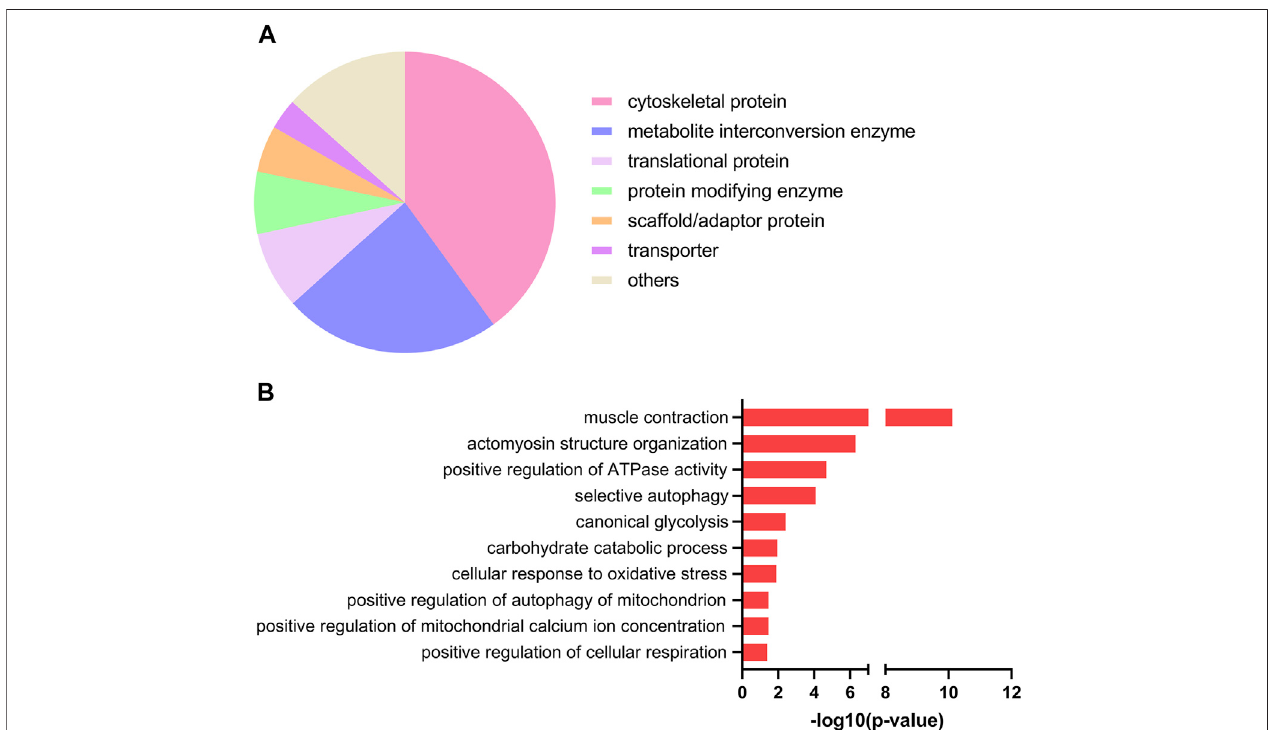
FIGURE 2 | Protein classi fi cation and selected gene ontology (GO)-biological processes of upregulated proteins in electrical pulse-stimulated myotubes from young male subjects. (A) Protein classes of differentially expressed proteins following electrical pulse stimulation (EPS) protocol 1. (B) Selected GO terms among signi fi cantly enriched biological processes.